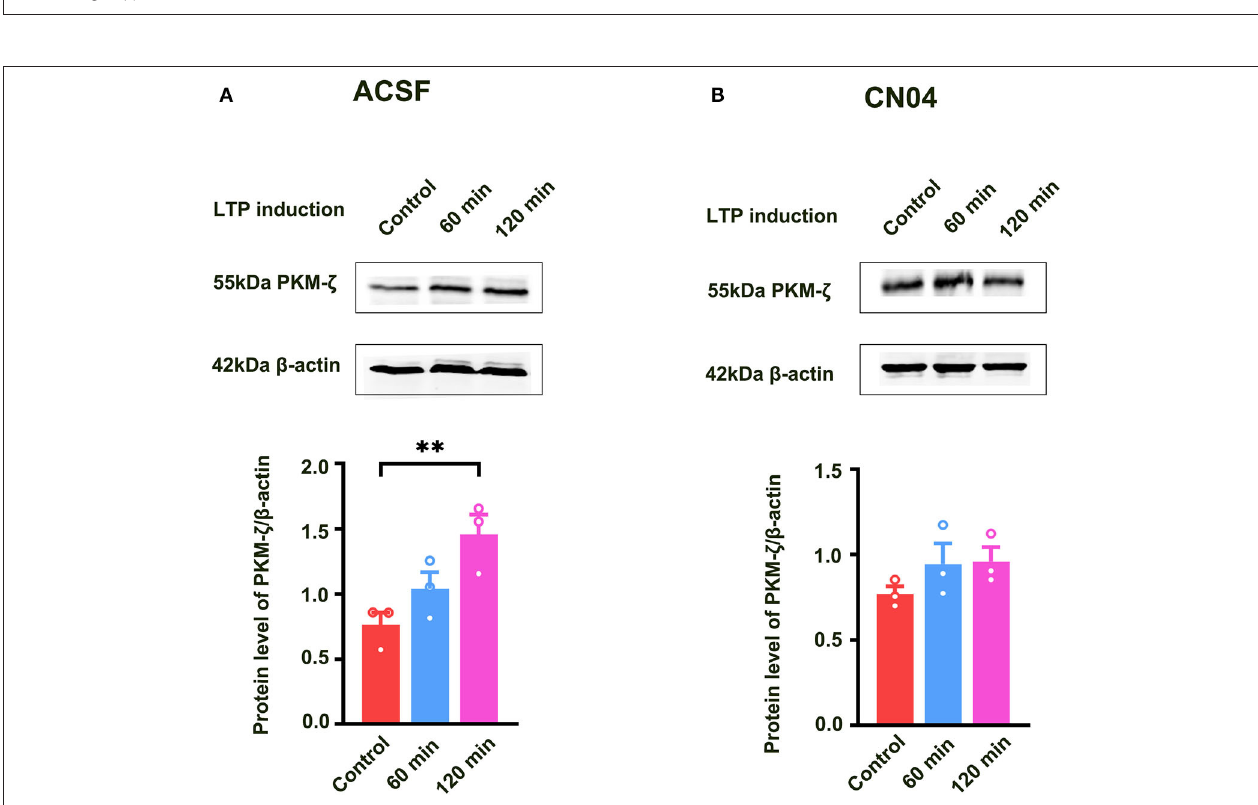
FIGURE 5 | Influence of Rac1 agonist CN04 on HFS-induced activation of PKM ζ . (A) Influence of three trains of HFS on PKM ζ expression (one-way ANOVA, ** P < 0.01, n = 3 in each group). (B) Influence of Rac1 agonist CN04 (424nM) on PKM ζ expression after giving HFS (one-way ANOVA, P > 0.05, n = 3 in each group). All data are shown as mean ±